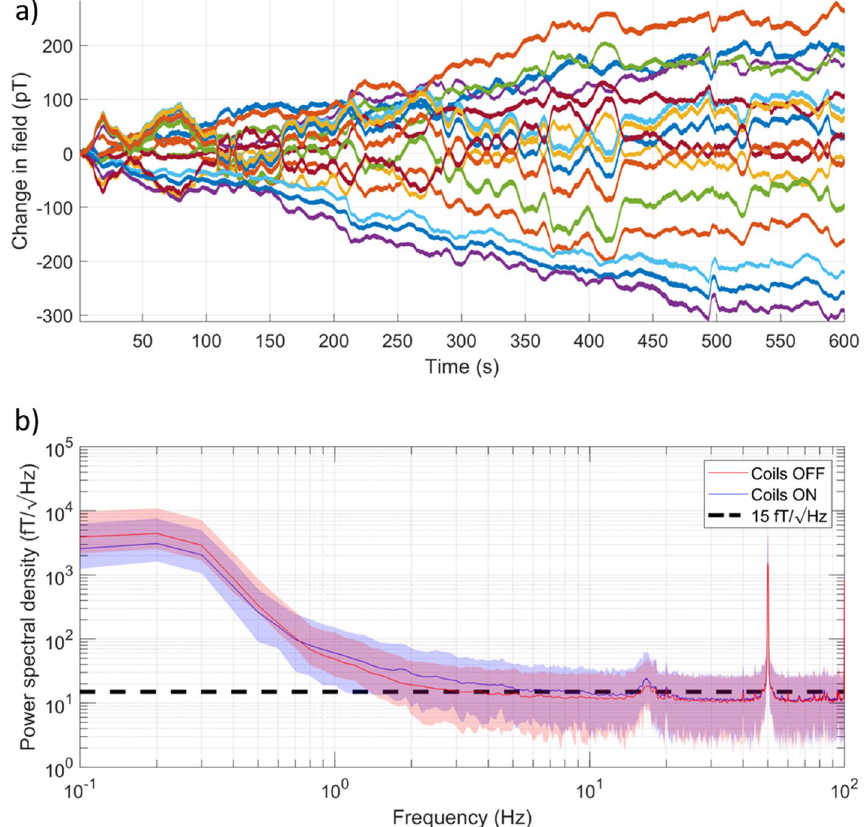
Figure 5. OPM data taken in the Light MuRoom. ( a ) Timecourses of the change in magnetic field experienced by eight dual-axis OPMs (16 total channels) which were placed at the centre of the empty MSR with the window coil system switched on. Each OPM was configured to measure two components of magnetic field. Over 10 min the change in field is ~ 300 pT indicating good shielding performance and a quiet magnetic environment. ( b ) Mean and range (shaded) of the power spectral density of the data collected from the OPMs with and without the window coil system active. The black dashed line indicates 15 fT/√Hz. Data suggests that the MSR is a suitable environment for OPM-MEG, and that the coil system does not add additional magnetic field